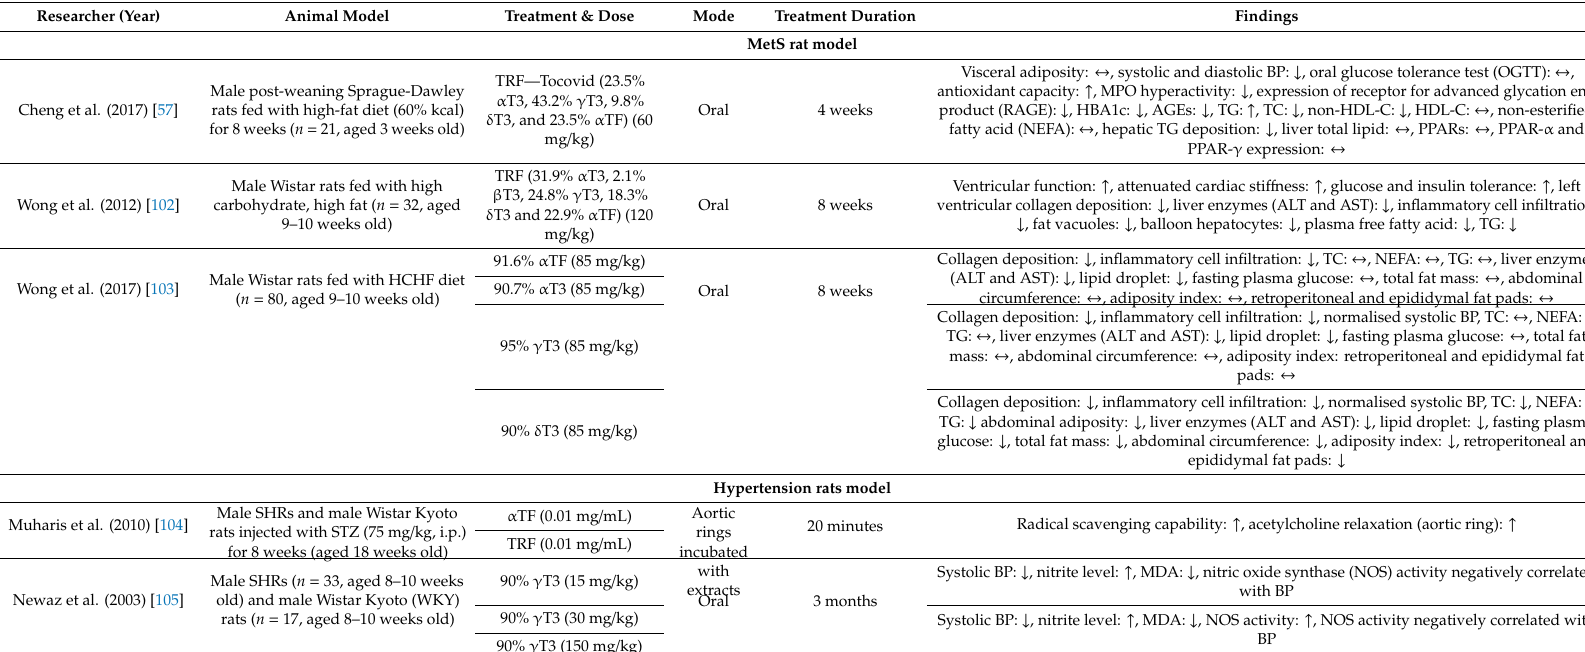
Ventricular function: ↑ , attenuated cardiac sti ff ness: ↑ , glucose and insulin tolerance: ↑ , left ventricularcollagendeposition: ↓ ,liverenzymes(ALTandAST): ↓ ,inflammatorycellinfiltration: ↓ , fat vacuoles: ↓ , balloon hepatocytes: ↓ , plasma free fatty acid: ↓ , TG: